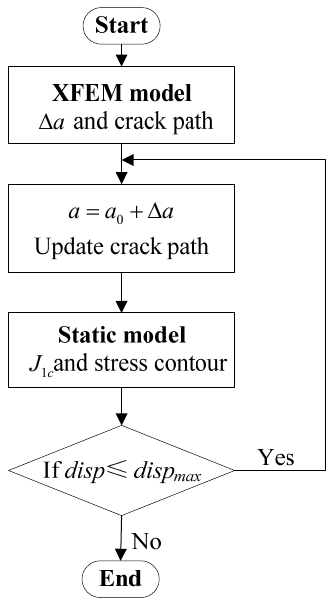
Figure 4. Calculation process.